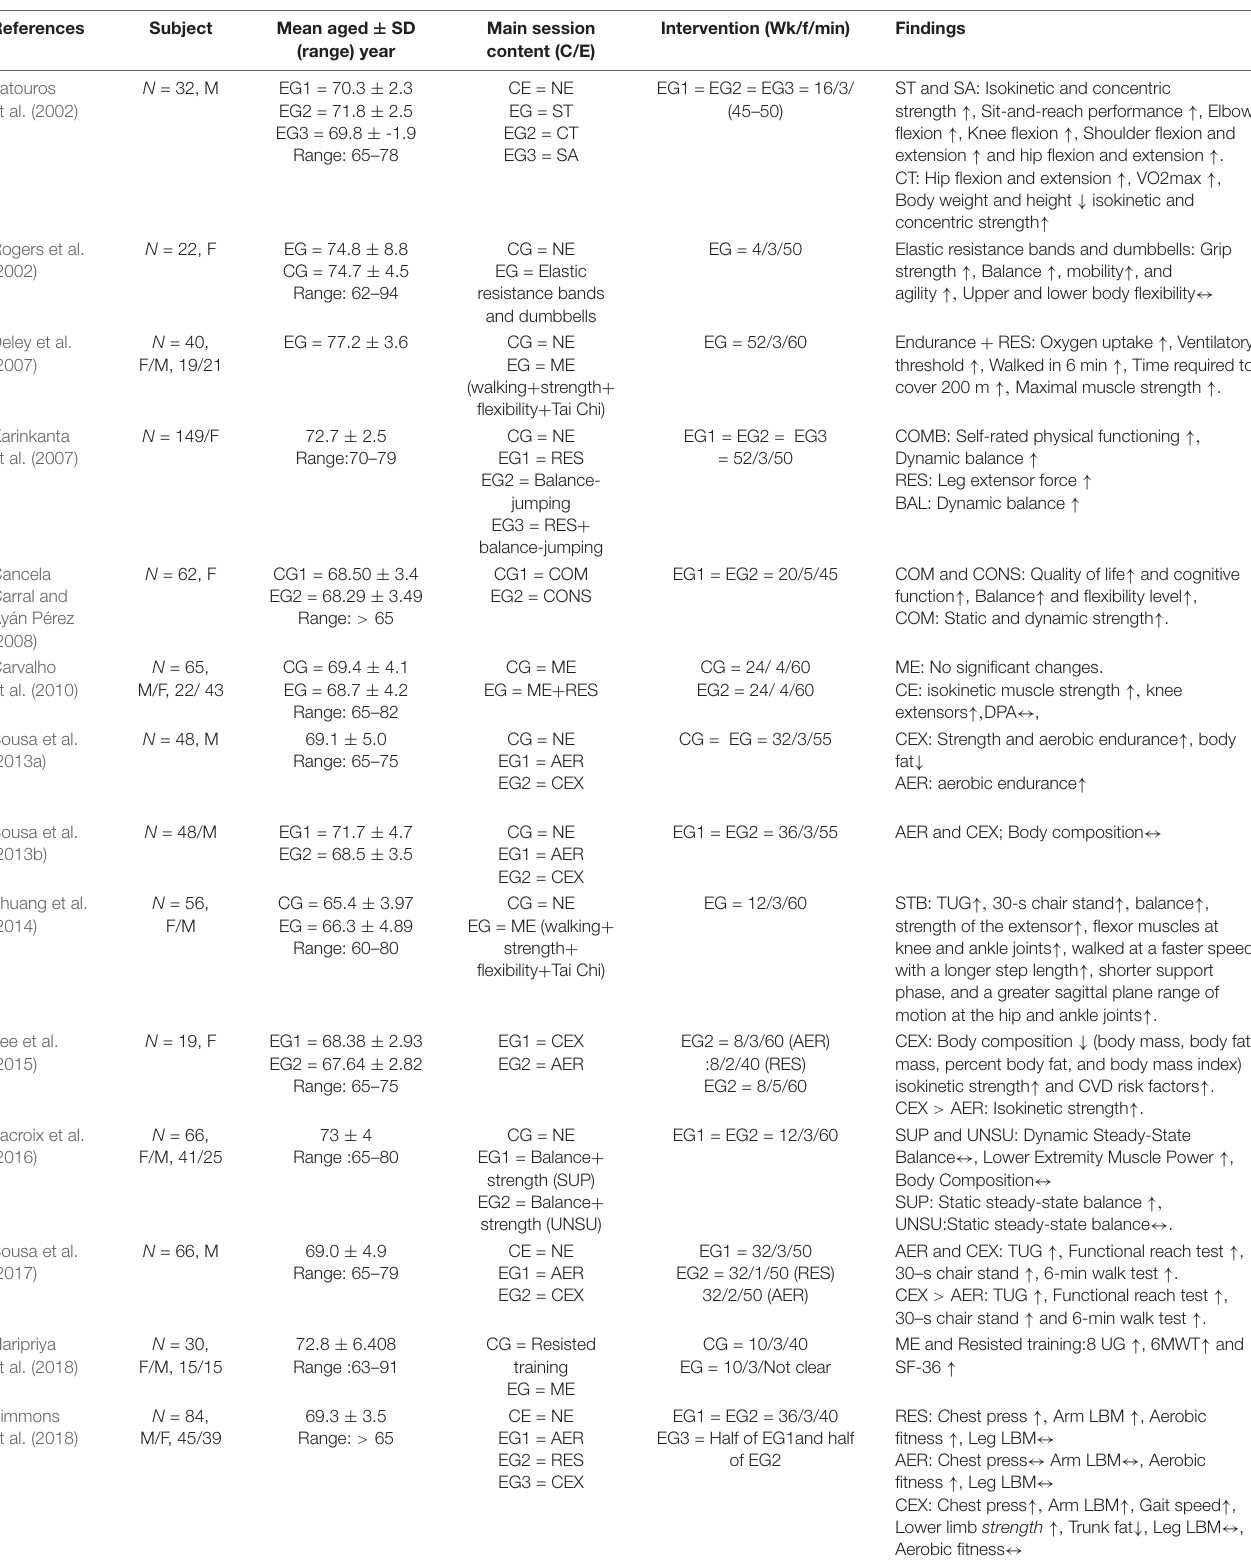
TABLE 3 | Summary of aerobic exercise combination to improve physical performance among